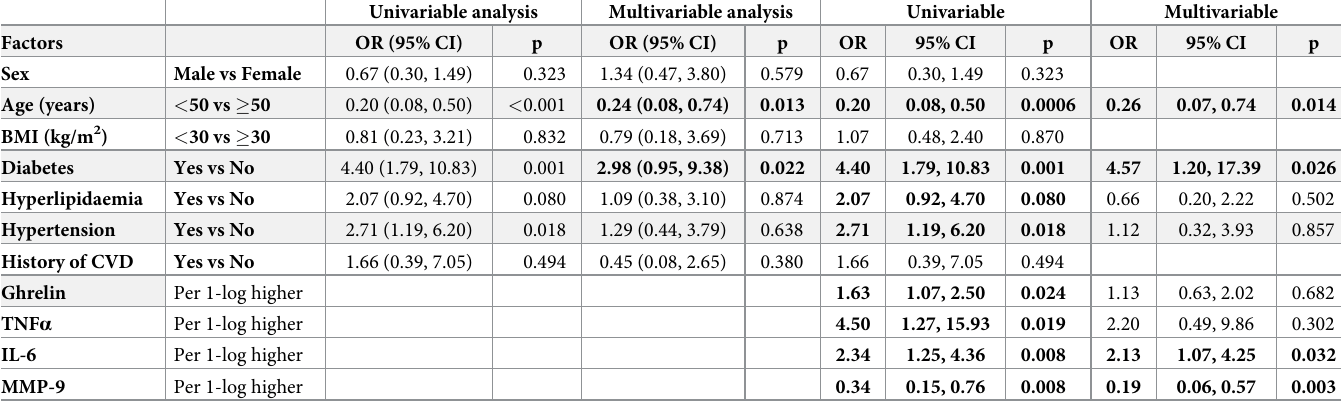
Table 3. a. Factors associated with Fibroscan result � 7.2 kPa. Logistic regression analysis in all study patients (n = 105). b. Multi-variable analysis of factors associated with Fibroscan result � 7.2